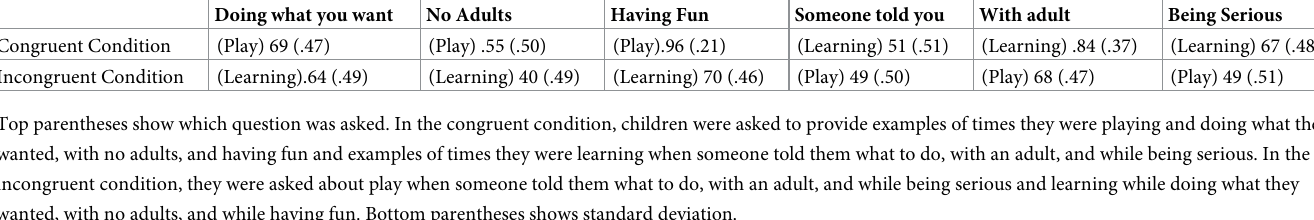
Table 3. Proportion of children who generated a valid example of play or learning (in parentheses) based on condition.